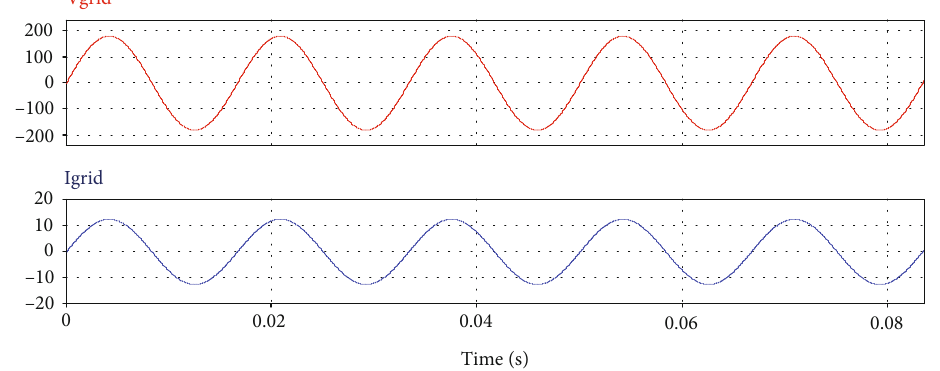
Figure 9: Active power injection fi lter with LCL. From top to bottom: average voltage (100V/div) and average current (10 A/div).